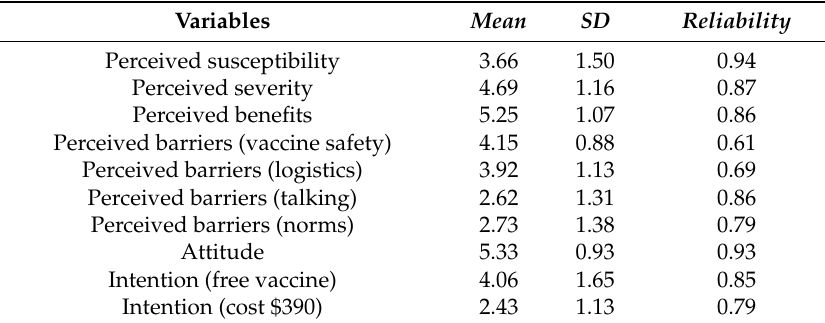
Table 2. Means and Standardized Deviation of Key Variables ( n =